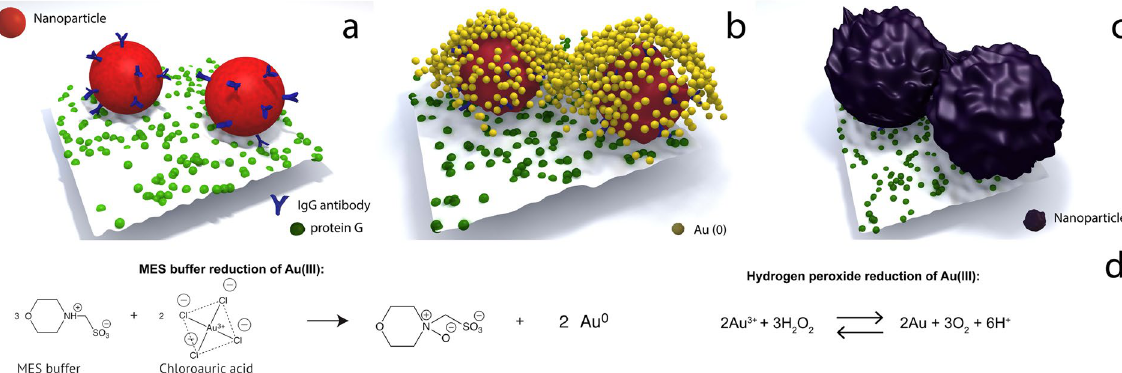
Figure 1. Illustration of ( a ) two neighbouring IgG-nanoprobes after detecting protein G immobilized on a microspot, ( b ) Incubation of the microspot array with enhancement solution and consequent seed-growth of the IgG-nanoprobes, ( c ) IgG-nanoprobes after 5 minutes of incubation with the enhancement solution and when the Au(0) atoms have been depleted and ( d ) chemical processes describing the reduction of Au(III) to